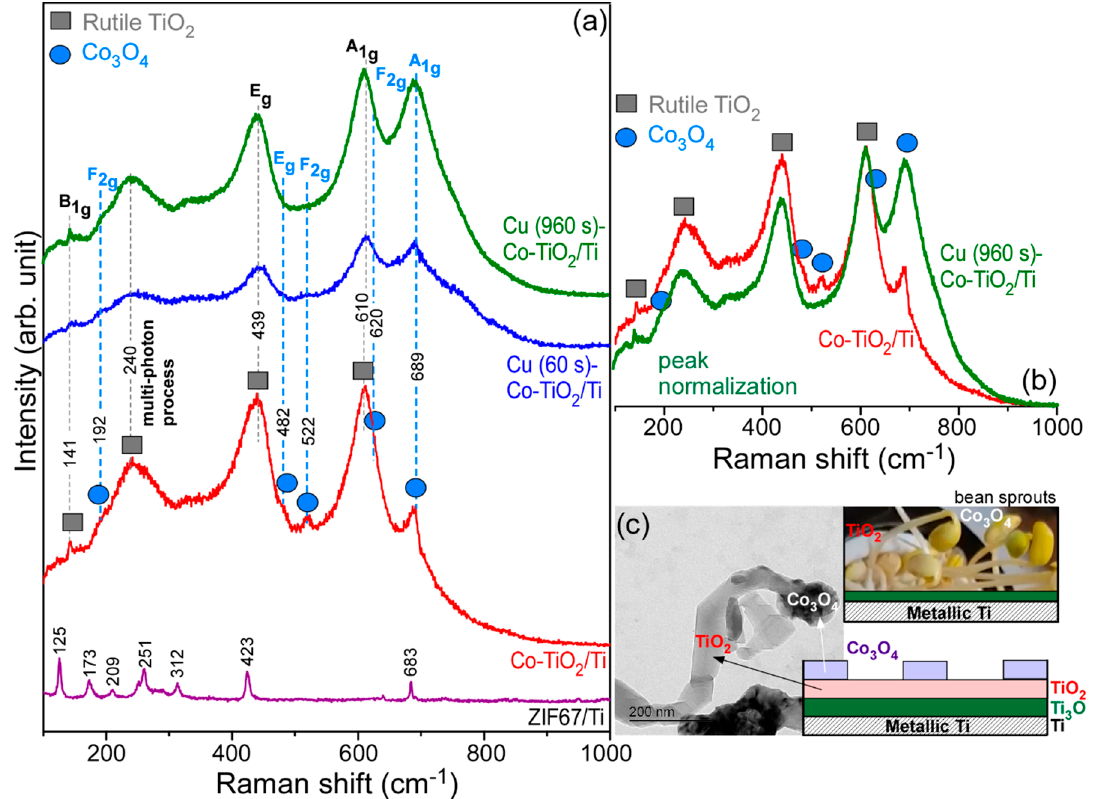
Figure 5. Raman spectra ( a ) of ZIF-67/Ti, Co-TiO 2 /Ti, Cu (60 s)-Co-TiO 2 /Ti and Cu (960 s)-Co-TiO 2 /Ti corresponding to normalized Raman spectra ( b ) before and after Cu deposition, and a schematic ( c ) of the material growth mode on metallic Ti surface upon thermal treatment.